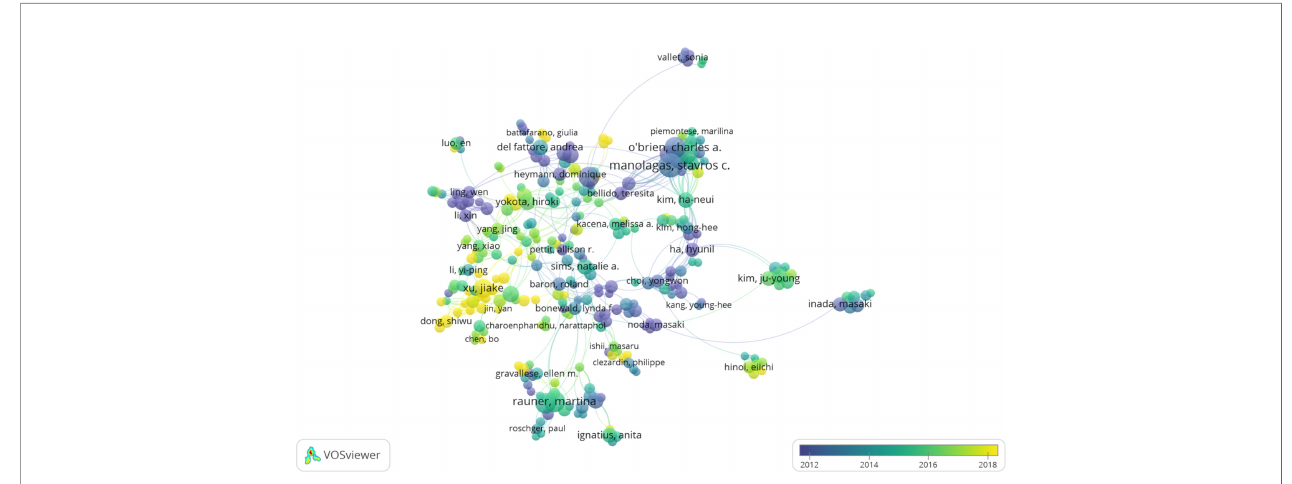
FIGURE 5 | The co-occurrence map of authors in osteoblasts-osteoclasts in bone disease (T ≥ 5). Notes: The size of node re fl ects the author ’ s co-occurrence frequencies, the link indicates the co-occurrence relationship between authors, and different node colors indicate different